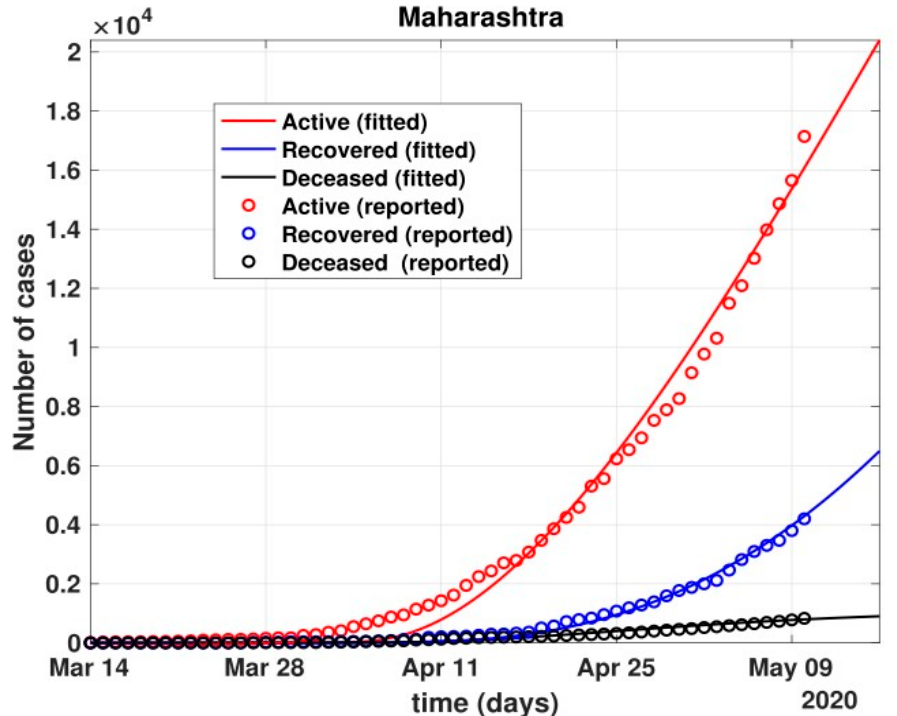
Figure 12. Fit of the proposed model (1) for the number of COVID-19 cases in Maharashtra.